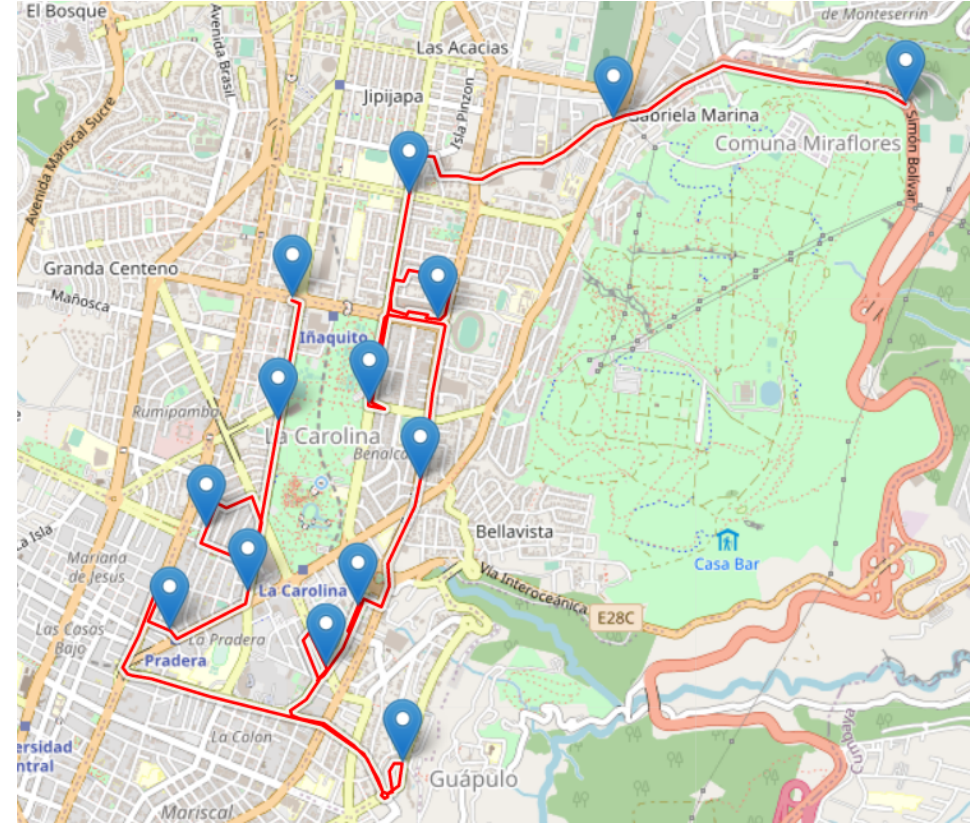
Figure 17. Resulting route by the Expert (blue icons are the